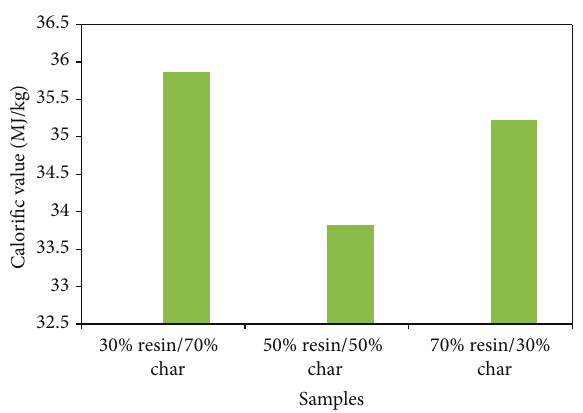
Figure 2: The calorific values of blended samples of resin and char.